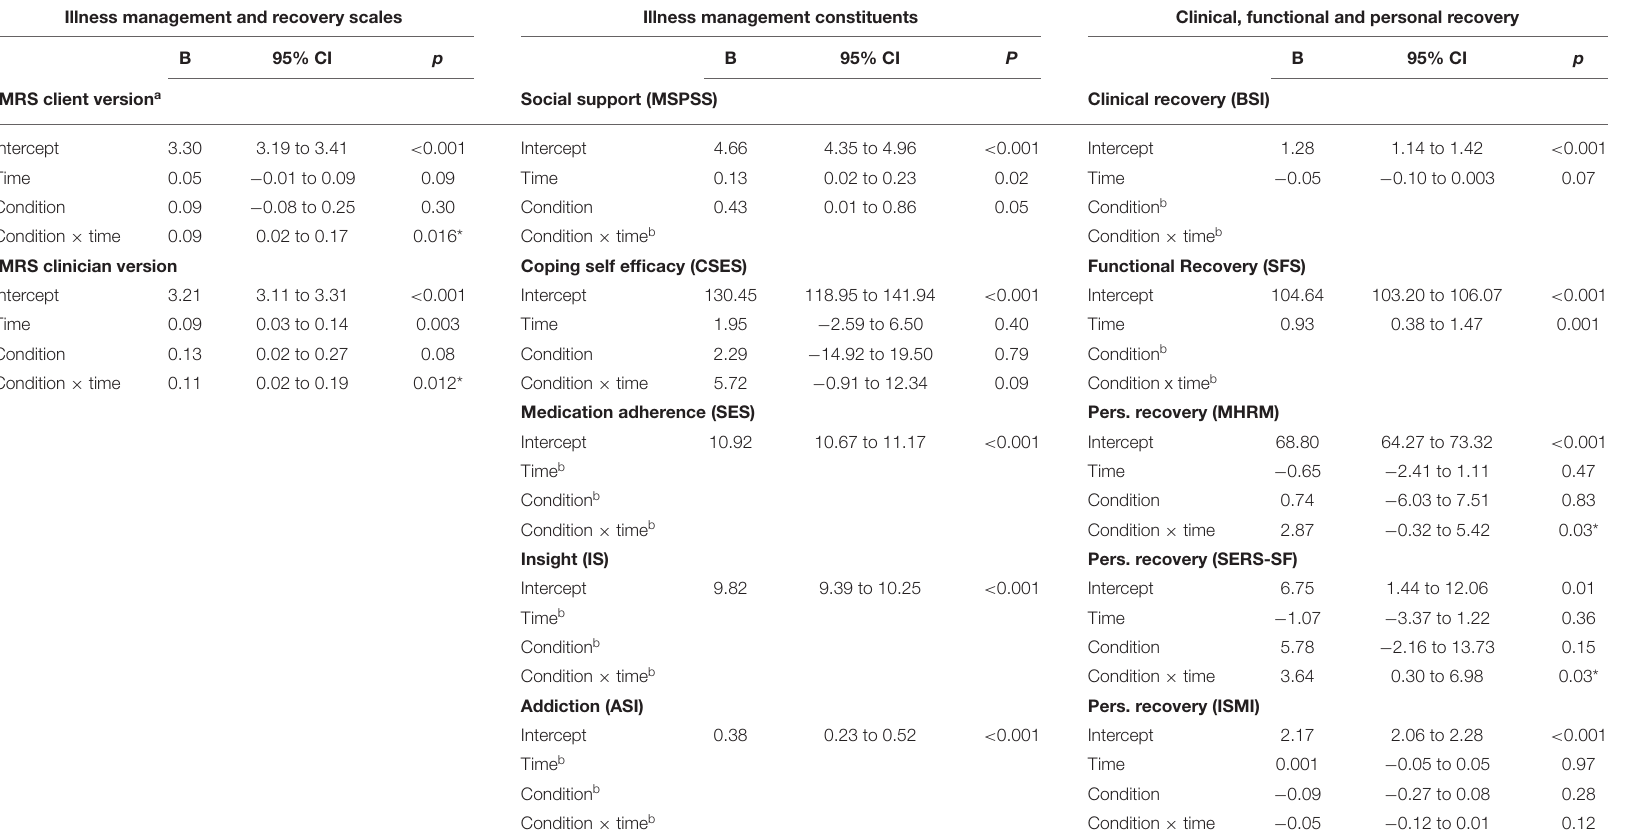
TABLE 6 | Fixed effects of IMR on all outcomes from final linear mixed model, in the completers